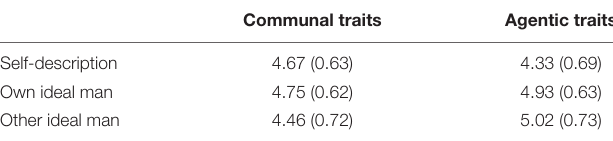
TABLE 1 | Means and standard deviations for Study 1 trait